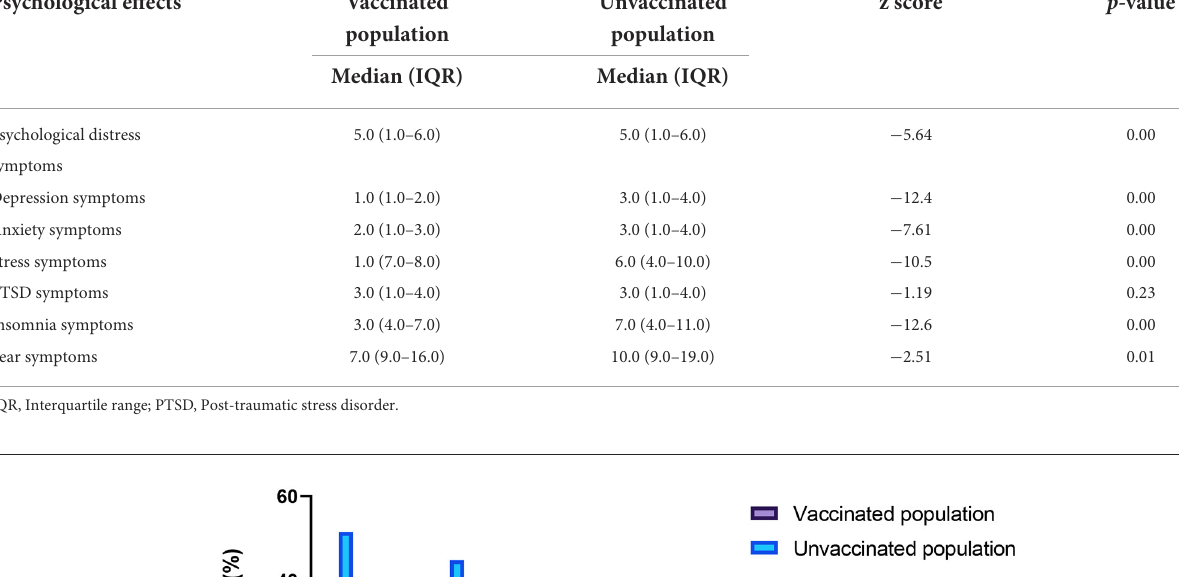
TABLE 2 The median of the interquartile range (IQR) of psychological effects scores in vaccinated and unvaccinated populations against COVID-19 infection. Psychological effects